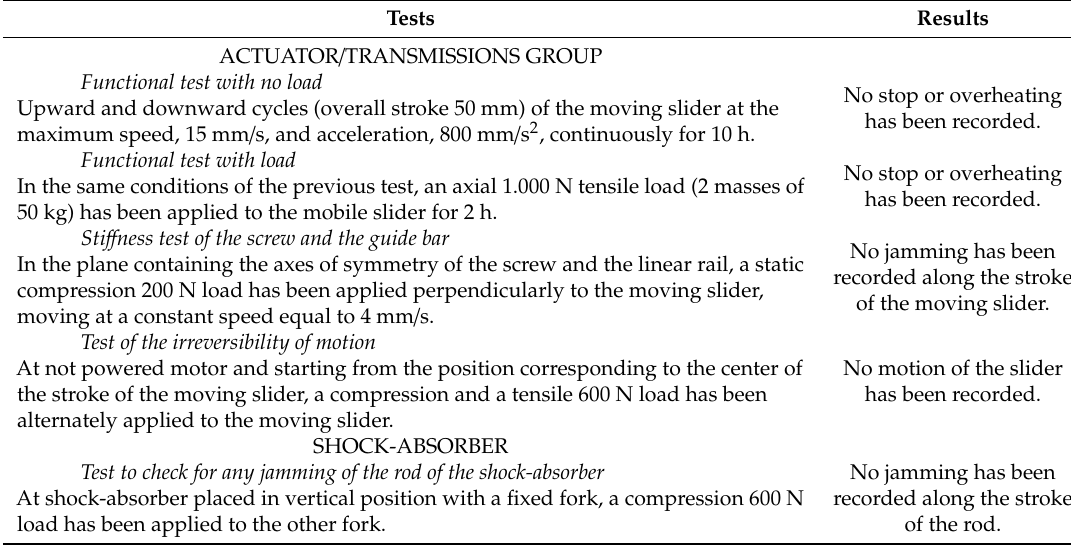
Table 6. Tests for the actuator / transmissions system and for the